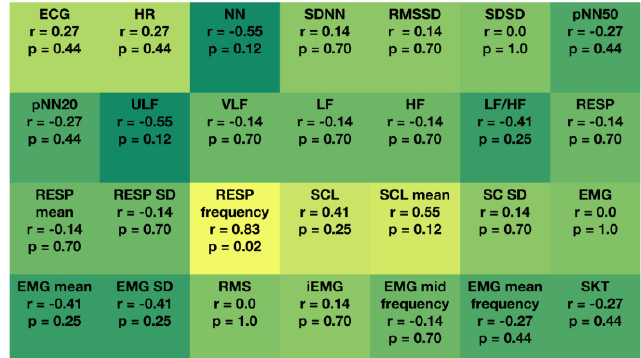
Figure 6. Kendall correlation analysis.